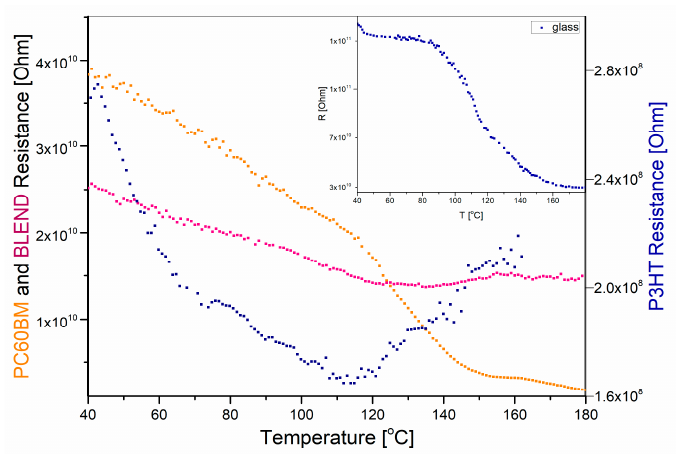
Figure 4. Electrical resistance as a function of temperature of indicated P3HT, PCBM and P3HT:PCBM blend films deposited on a glass substrates. Inset: glass resistance.